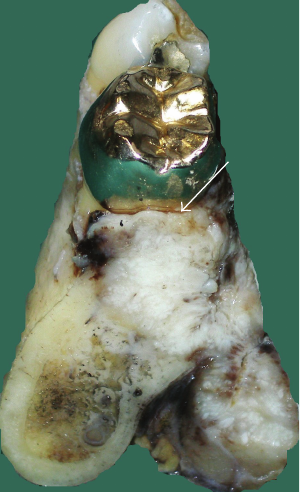
Figure 6: Case 2—cross section specimen with a sectional view from distal after removal of the bony aspect that contained the wisdom tooth. The tumor is in broad contact to the periodontium (arrow) with infiltration of the adjacent cancellous bone and the floor of the mouth.